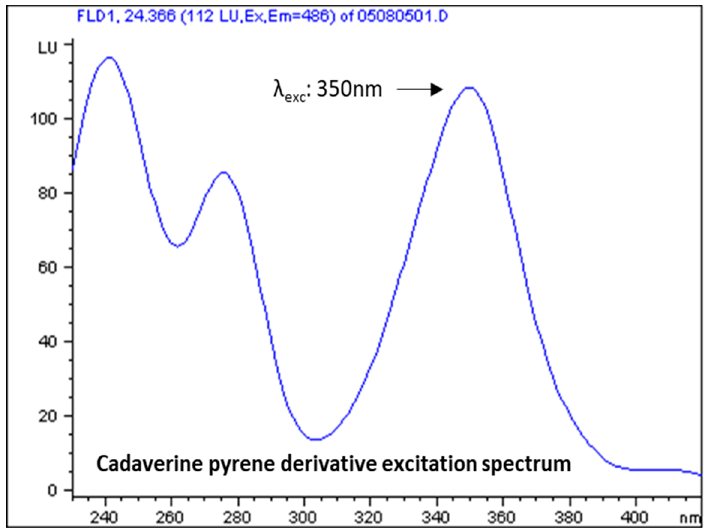
Figure 5. Excitation spectrum of cadaverine pyrene derivative chromatographic peak. Retention time approximately 24 min.